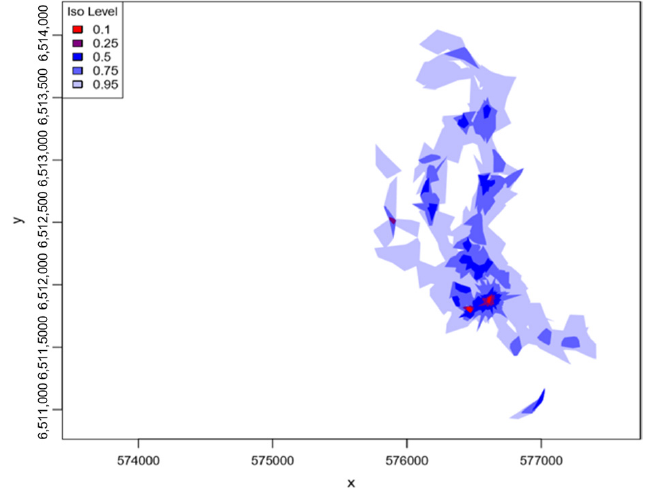
Figure 4. Isopleths constructed in different hulls sorted by area, indicating proportions of the total points enclosed by cattle during the dry season.